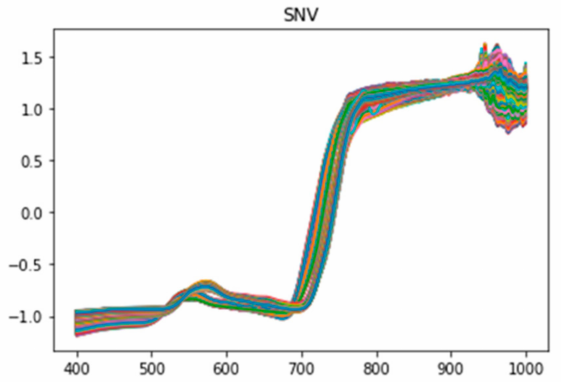
Figure A2. Spectrum corrected by standard normal variate (SNV). X-axis represents wavelength of feature (Unit: nm) while Y-axis represents standardized reflection value. The color of lines represents each reflectance value of grass samples.